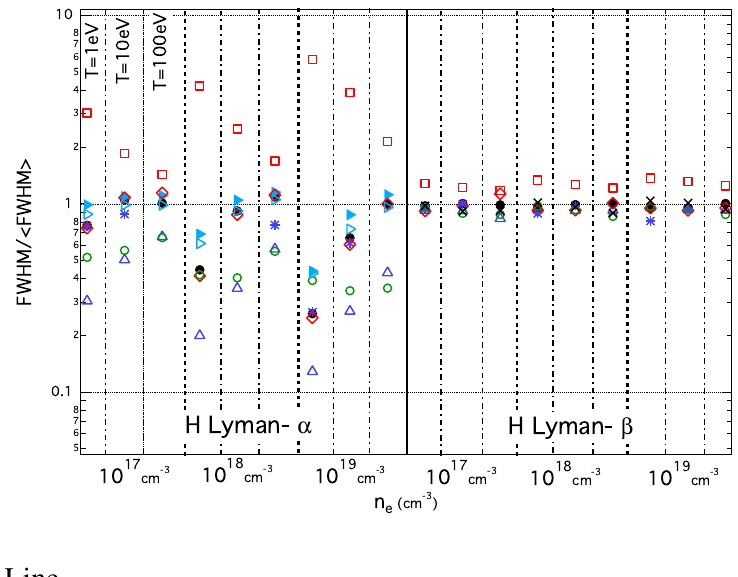
correspond to: (black dot) SimU; (red square) UTPP; (blue triangle) PPP; (blue